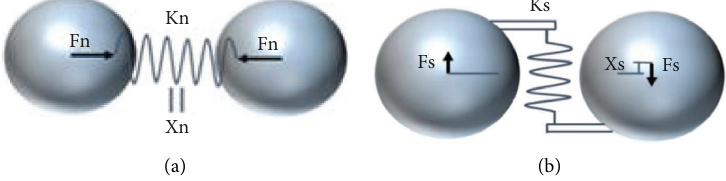
Figure 5: Contact model of adjacent soil elements. (a) Compression. (b) Shear.